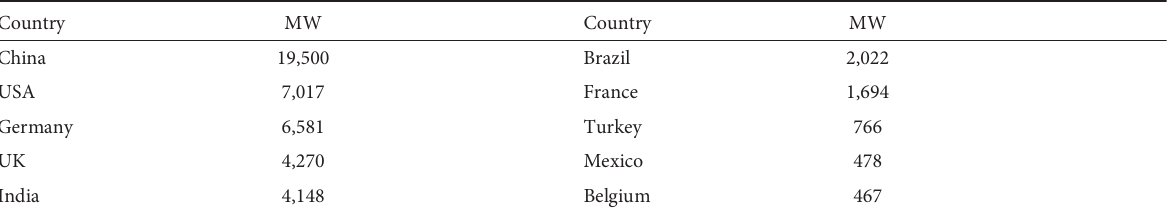
Figure 1: Distribution of the global wind power installed capacity in